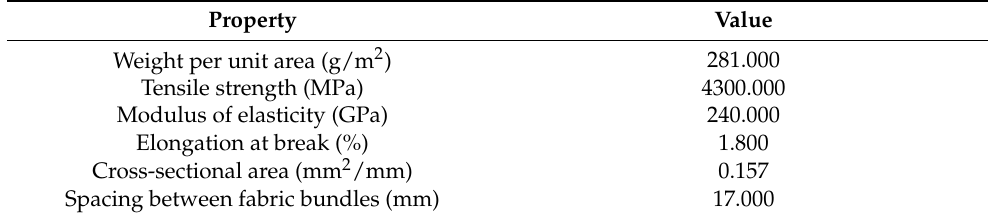
Figure 2. Carbon fabrics: ( a ) Fabric net; ( b ) Close view showing the fiber strands. Table 3. Fabric properties data from [31].